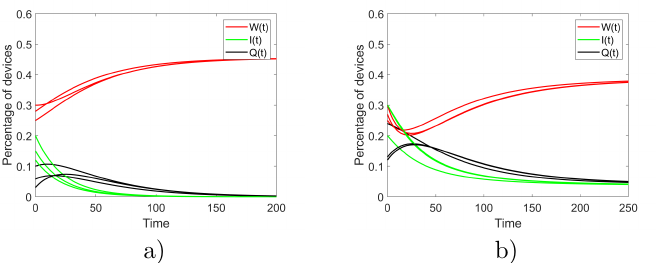
Figure 4. Time variation of system (3.2) with parameters given in (a) Example 3 and (b) Example 4 for various initial